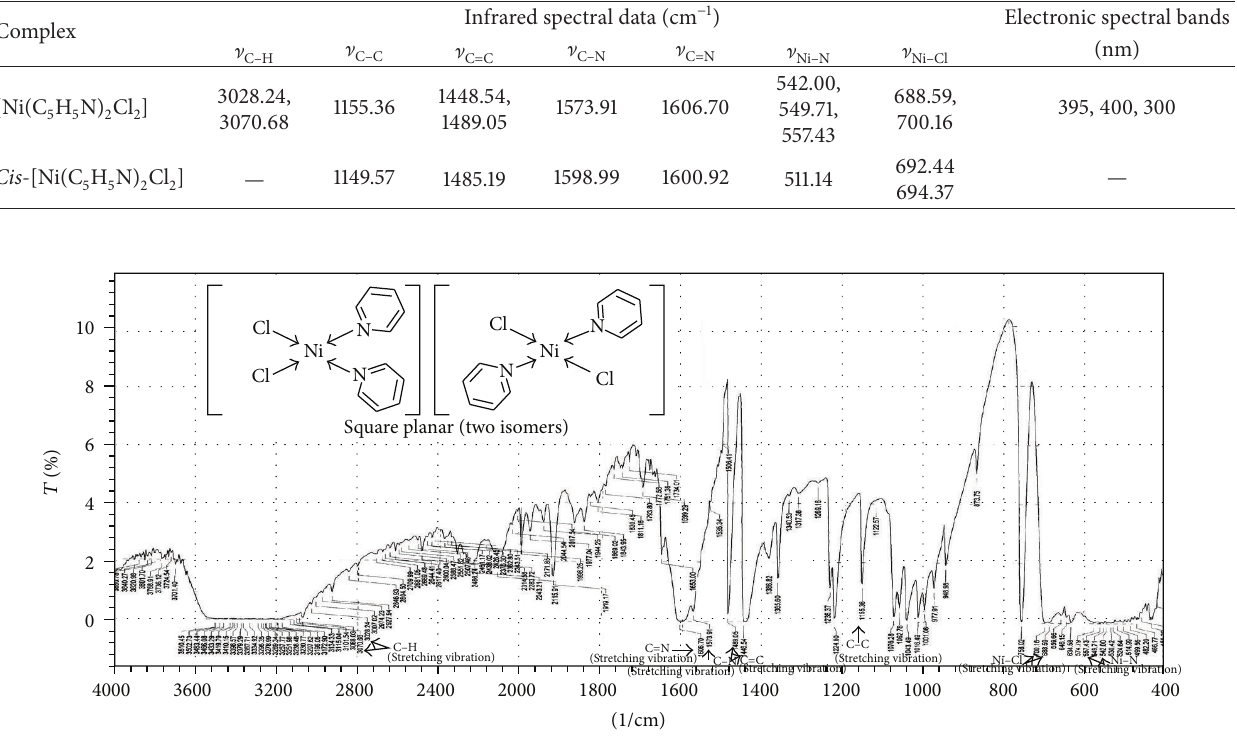
Figure 1: Infrared spectrum of [Ni(C 5 H 5 N) 2 Cl 2 ].